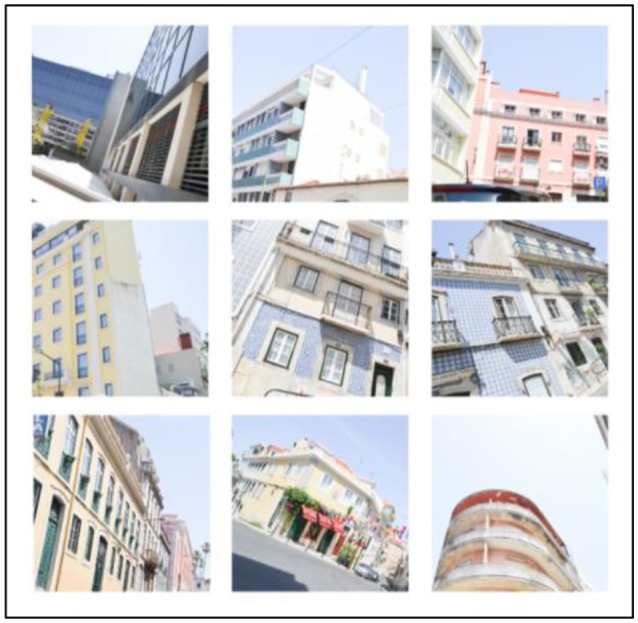
Some examples of the randomly shot photographs from study 2.